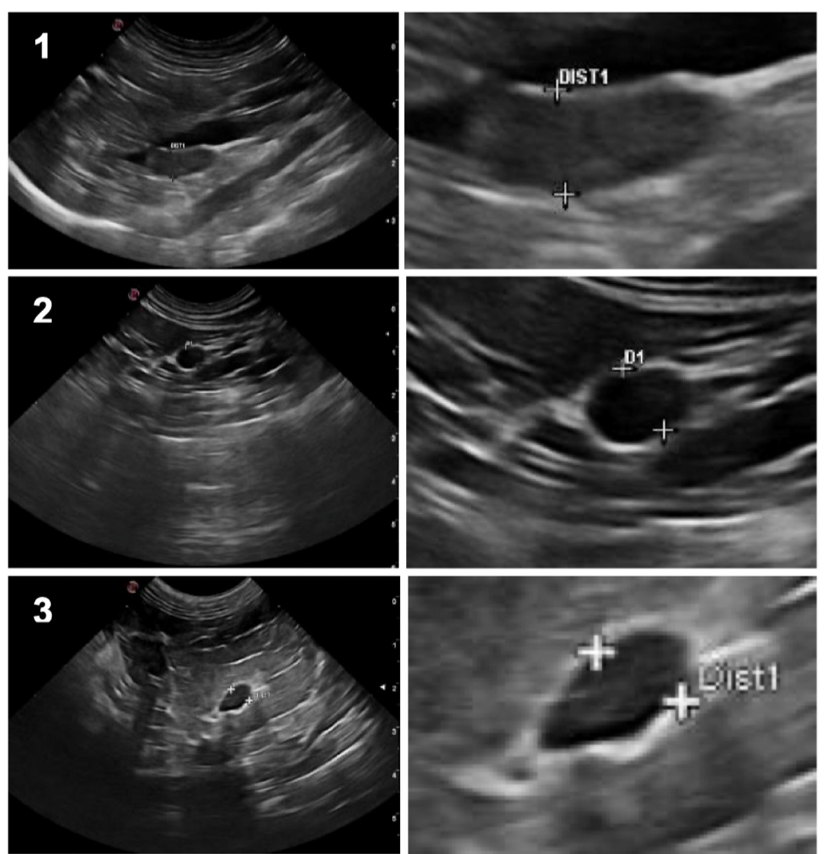
Figure 1. On the left column: Ultrasound still images illustrating the three different shapes of feline adrenal glands: 1. Bipolar; 2. Oval; 3. Fusiform; On the right column: respective “zoom-in” image, showing the dorsoventral axis measurement.